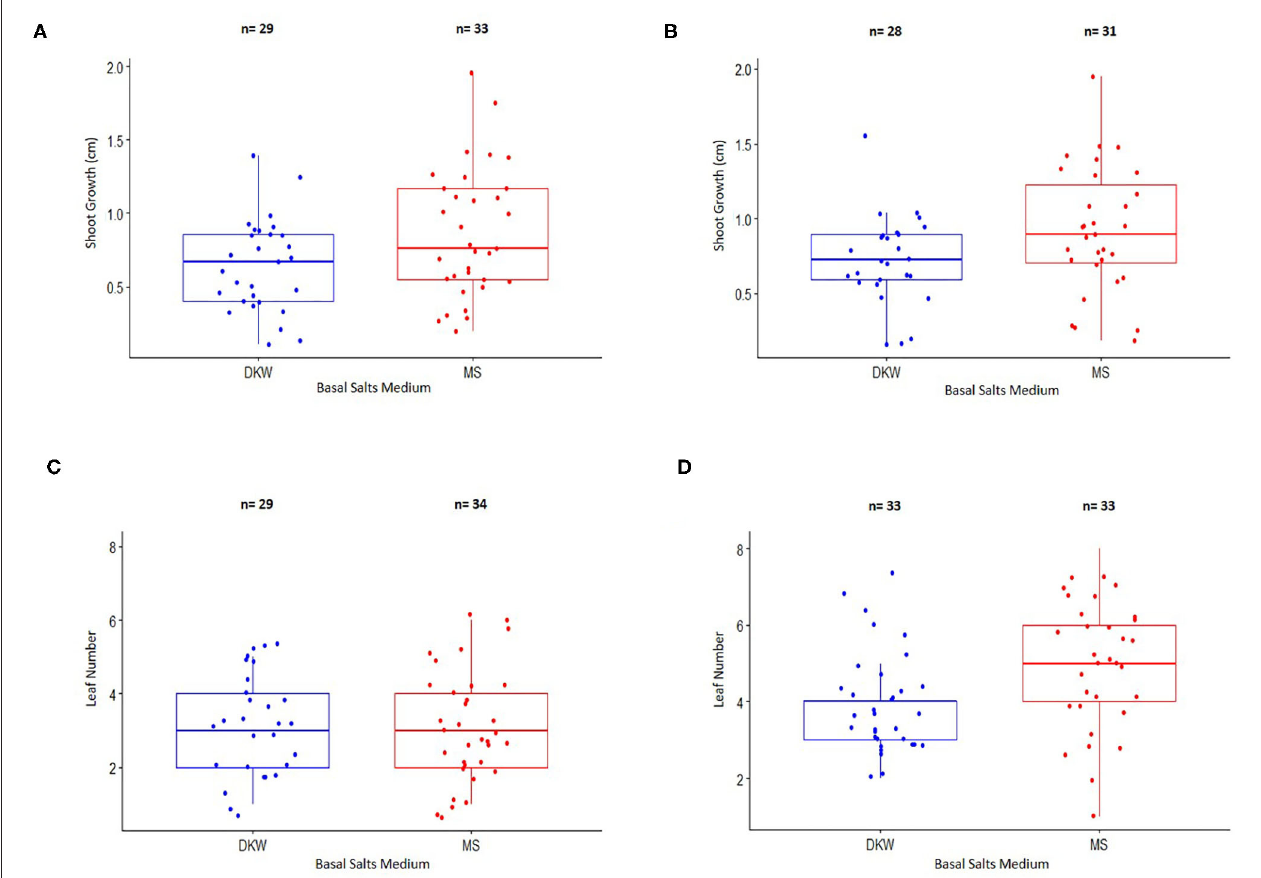
FIGURE 3 | Comparison of shoot growth and leaf number from nodal stem explants of two cannabis genotypes placed on a basal salt medium containing either Driver and Kuniyuki Walnut (DKW) or Murashige and Skoog (MS) salts. (A) Shoot length of genotype Copenhagen Kush (CPH). (B) Shoot length of genotype Pennywise (PWE). (C) Leaf number of genotype Copenhagen Kush (CPH). (D) Leaf numbers of genotype Pennywise (PWE). The box of each dataset represents the interquartile range (IQR), which contains the third quartile (Q3–top side of the box), the median value of all of the data (the middle line), and the first quartile (Q1–bottom side of the box). The bars represent the maximum (Q3 + 1.5*IQR) and minimum (Q1–1.5*IQR) of the data. The numbers ( n ) above the bars depict explant numbers